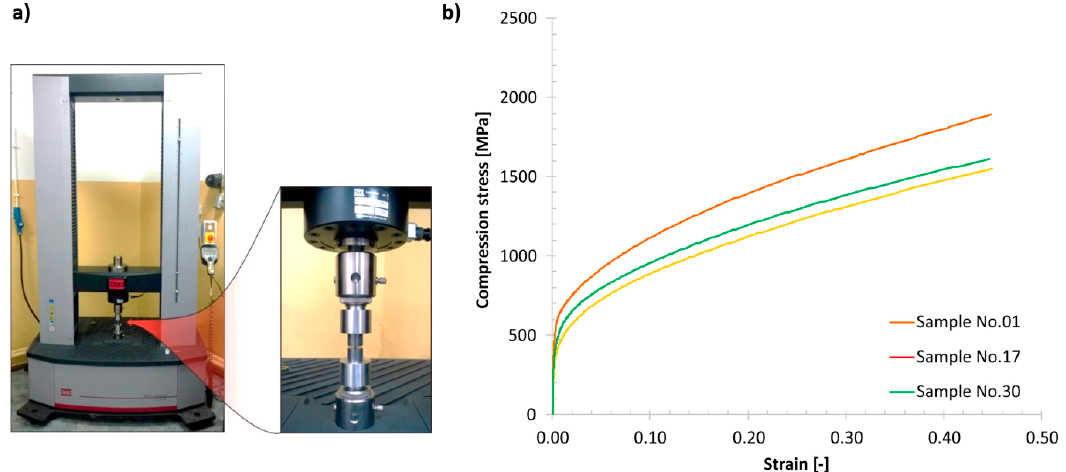
Figure 14. ( a ) Universal strength machine with a detailed view of the specimen mounting assembly, and ( b ) compression plots obtained for various 316L material samples.